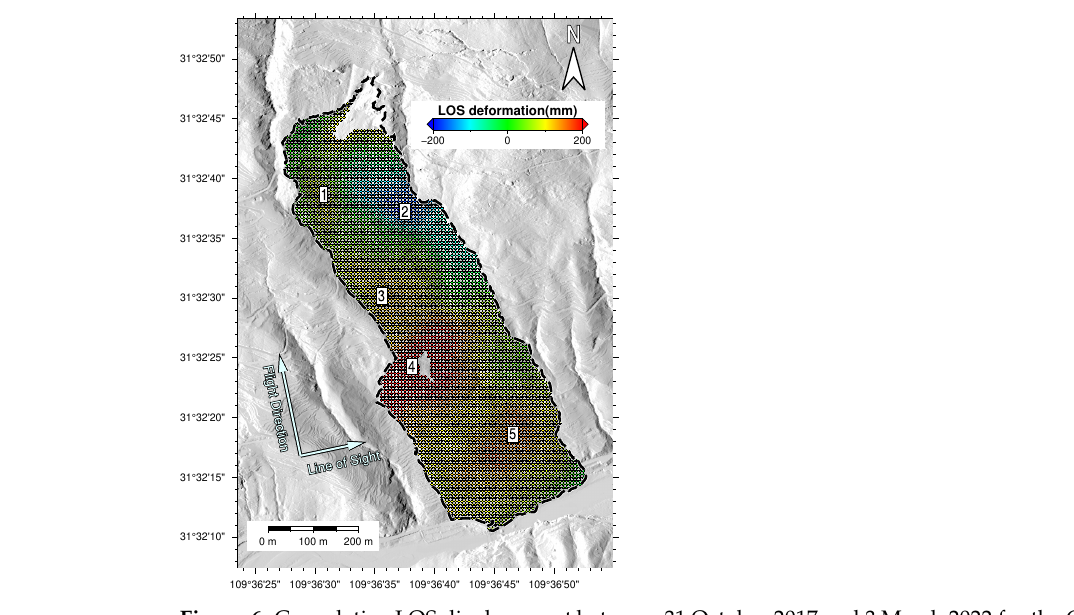
Figure 6. Cumulative LOS displacement between 31 October 2017 and 3 March 2022 for the Guang’an Village Landslide. The numbers 1 to 5 indicate the five active deformation zones for Figure 7.